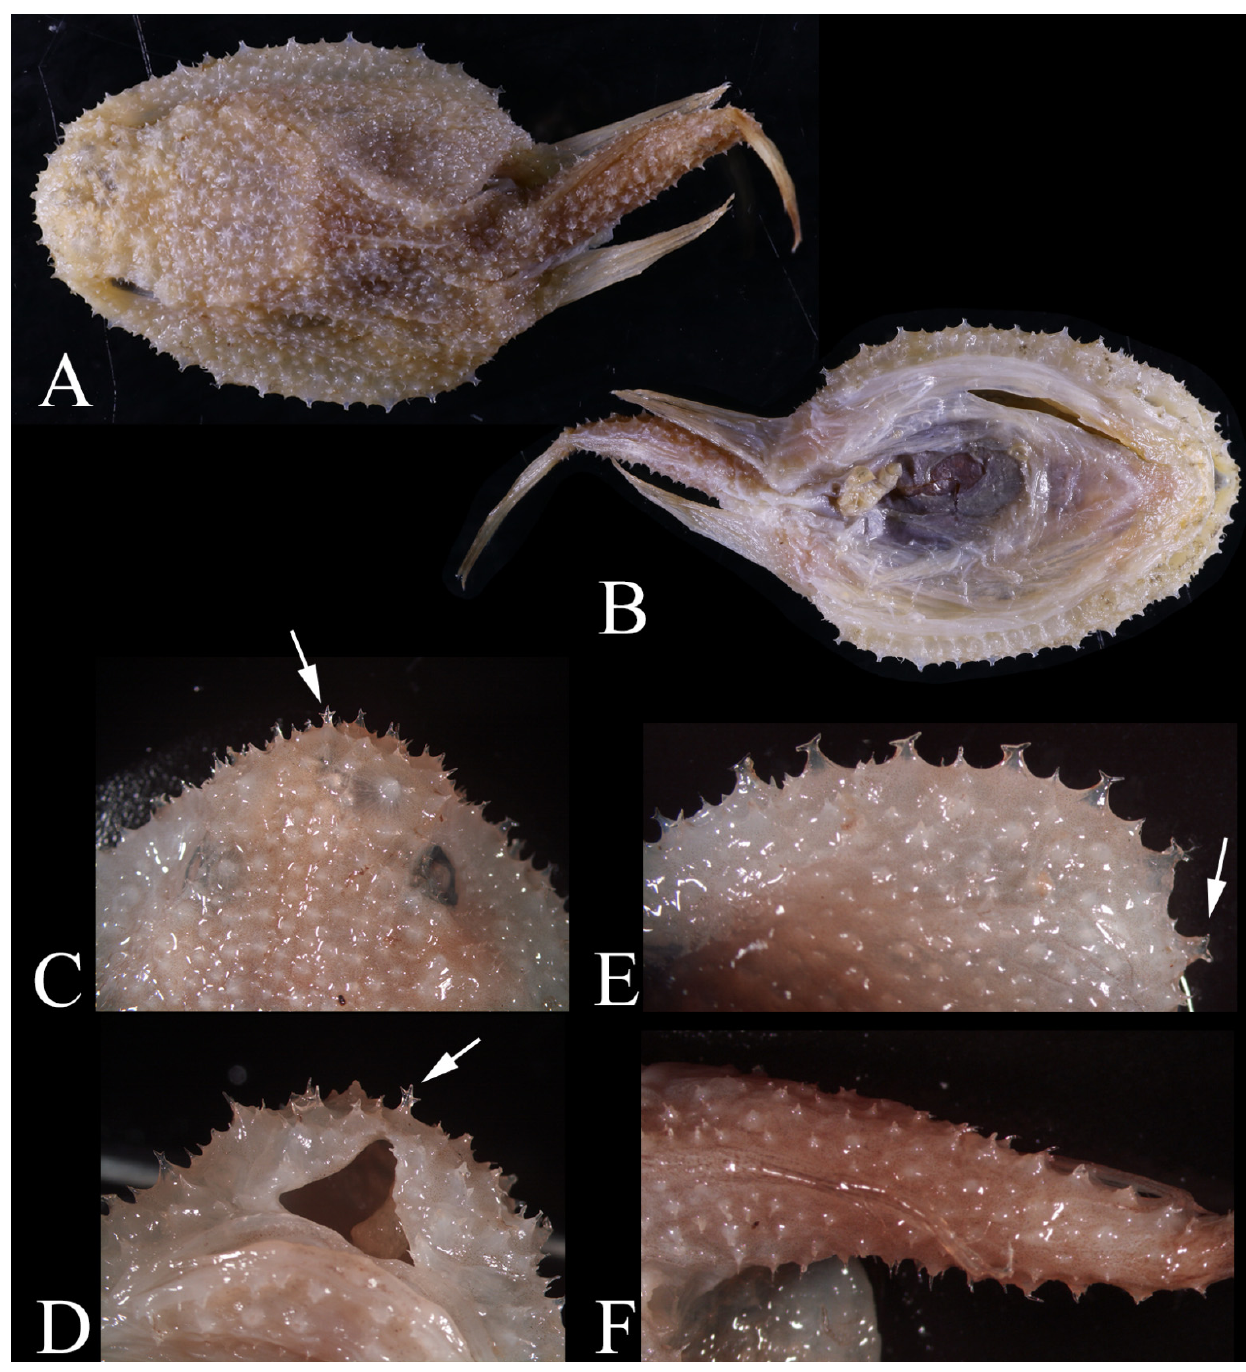
Figure 31. Halieutopsis simula (Smith and Radcliffe, 1912). ( A , B ). ASIZP 57202, 67.1 mm SL, Taiwan, photos by C.-N. Tang. ( C – F ). AMS I.22809-049, 41.2 mm SL, Northwest Shelf, Australia. ( A ). Dorsal view. ( B ). Ventral view. ( C ). Dorsal view of head, with arrow pointing to rostral tubercle. ( D ). Ventral view of rostrum, with arrow pointing to rostral tubercle. ( E ). Disk margin, with arrow pointing to subopercular tubercle. ( F ). Dorsal view of tail.